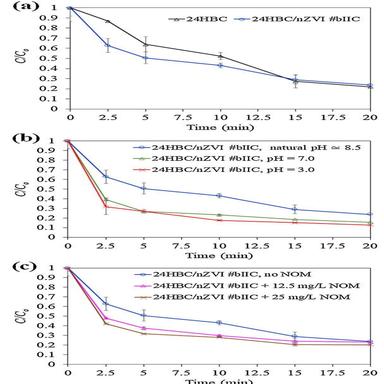
TCE removal efficiency using 24HBC/nZVI #bIIC (a) compared with 24HBC in natural pH ' 8.5 with no added NOM, (b) in natural pH ' 8.5, pH = 3.0, and pH = 7.0 with no added NOM, and (c) with 0, 12.5, and 25.0 mg L1 NOM added in natural pH ' 8.5. Adsorbent dose = 250 mg L1 . Error bars denote standard deviations.